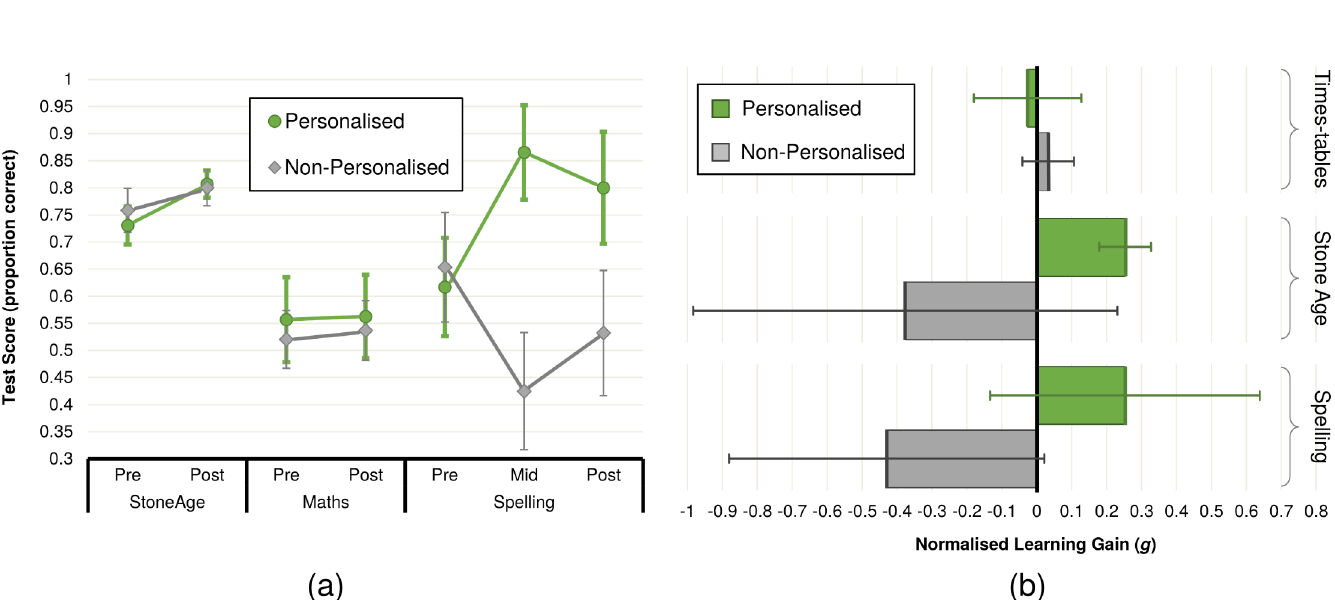
PLOS ONE | https://doi.org/10.1371/journal.pone.0178126 May 23,